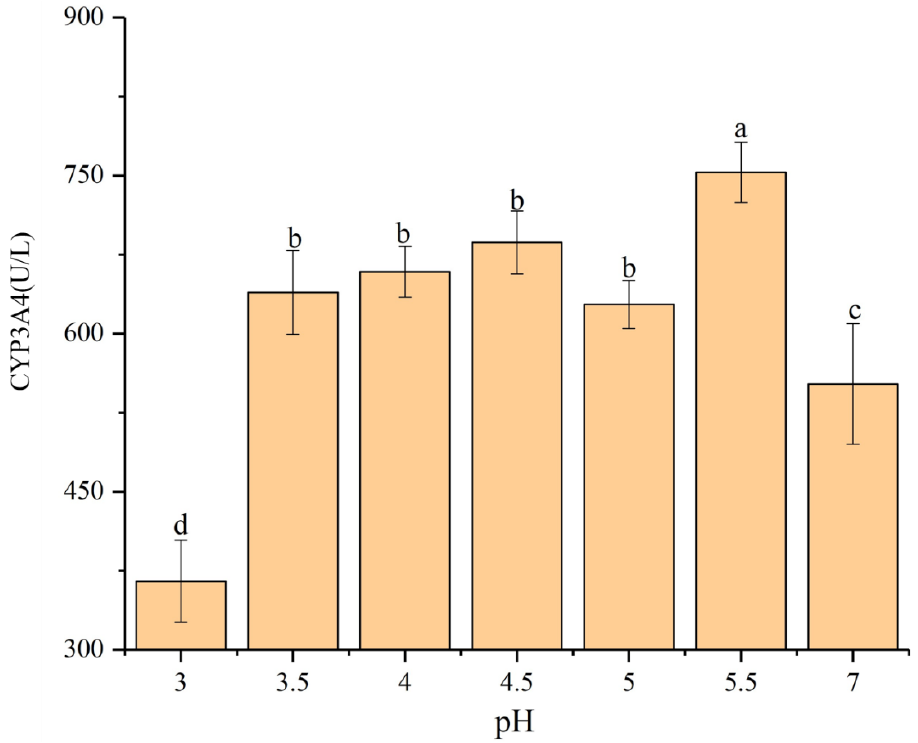
Figure 13. CYP3A4 enzyme activity in adult Eisenia fetida exposed to control soil and acid rain contaminated soil with eight pH levels for 15 days ( n = 10). Error bars indicate standard error of the means ( n = 10). Different letters indicate significant difference among treatments ( p < 0.05).